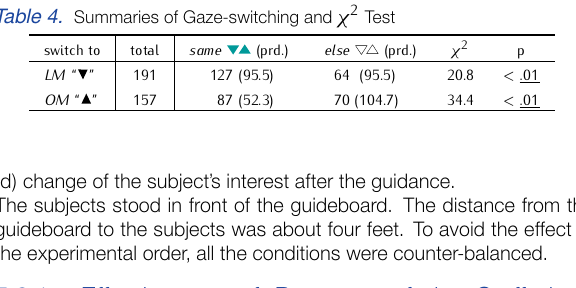
Figure 14. Experimental Environment for Gaze-reactive Robot Guide